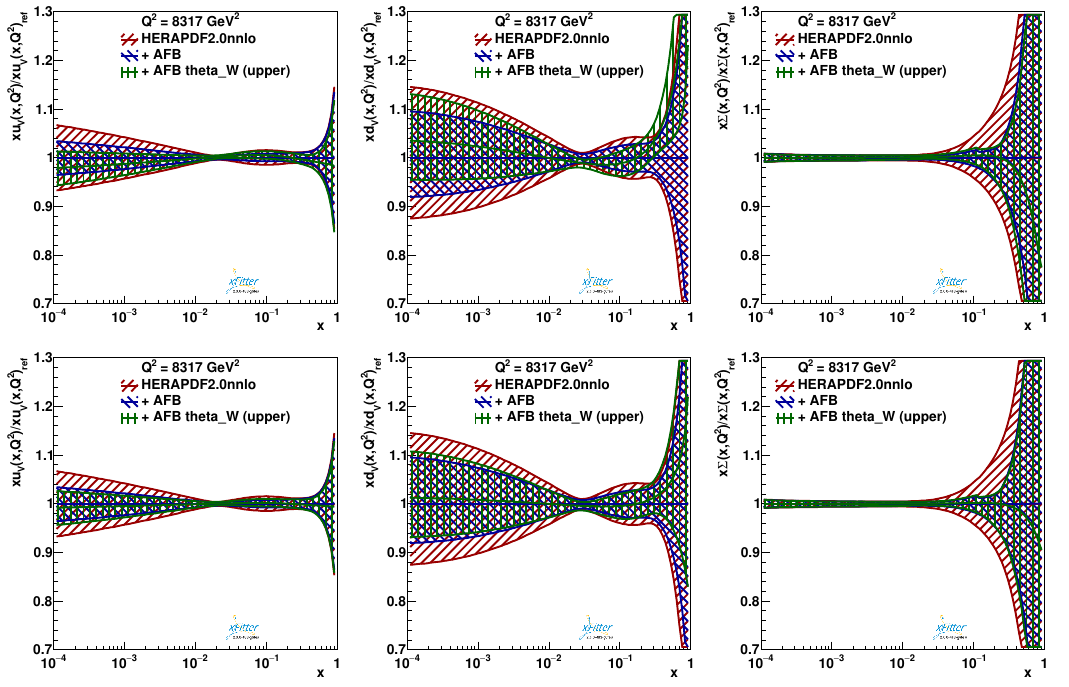
Figure 8 . Pro(cid:12)led curves obtained using the upper limit of sin 2 (cid:18) W allowed by LEP-SLD mea- surements (top row) and by a global (cid:12)t of electroweak parameters (bottom row). The pseudodata correspond to an integrated luminosity of 3000 fb (cid:0) 1